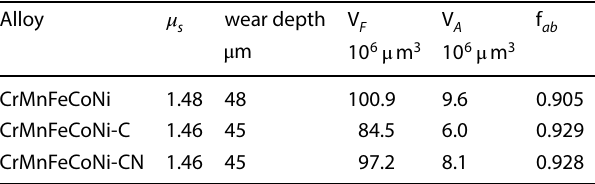
Table 5 Average friction coefficient μ s , groove depth, groove vol- ume ( V F ), pile-up volume ( V A ), f ab coefficient Alloy